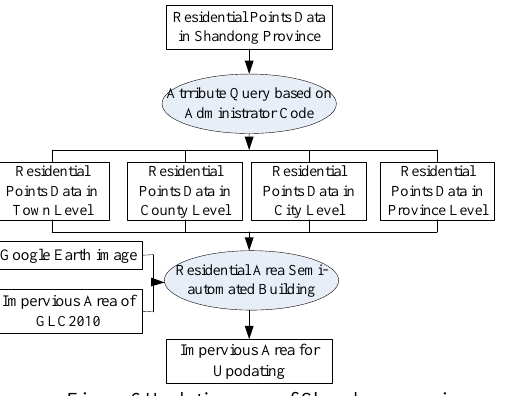
Figure 6.Updating area of Shandong province